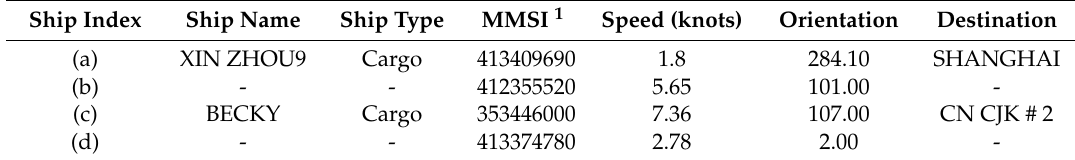
Table 7. The detailed AIS information on the 4 missing detected ships.